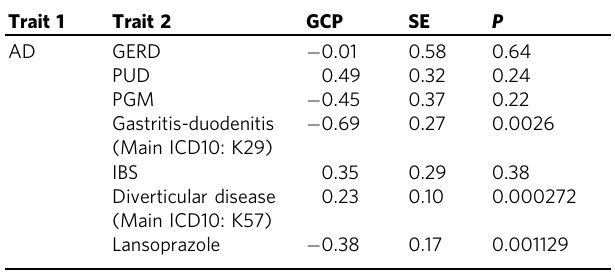
Table 6 Partial causality assessment using the Latent Causal Variable approach.